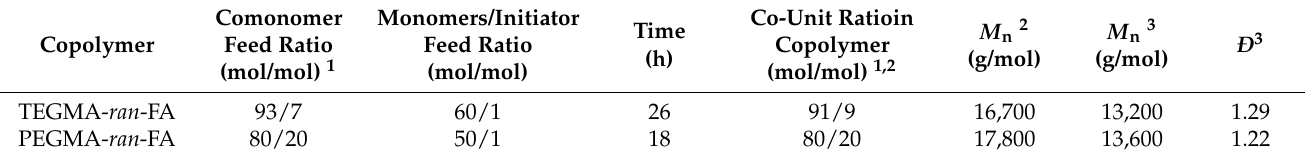
Table 1. Polymerization data for amphiphilic random copolymers.